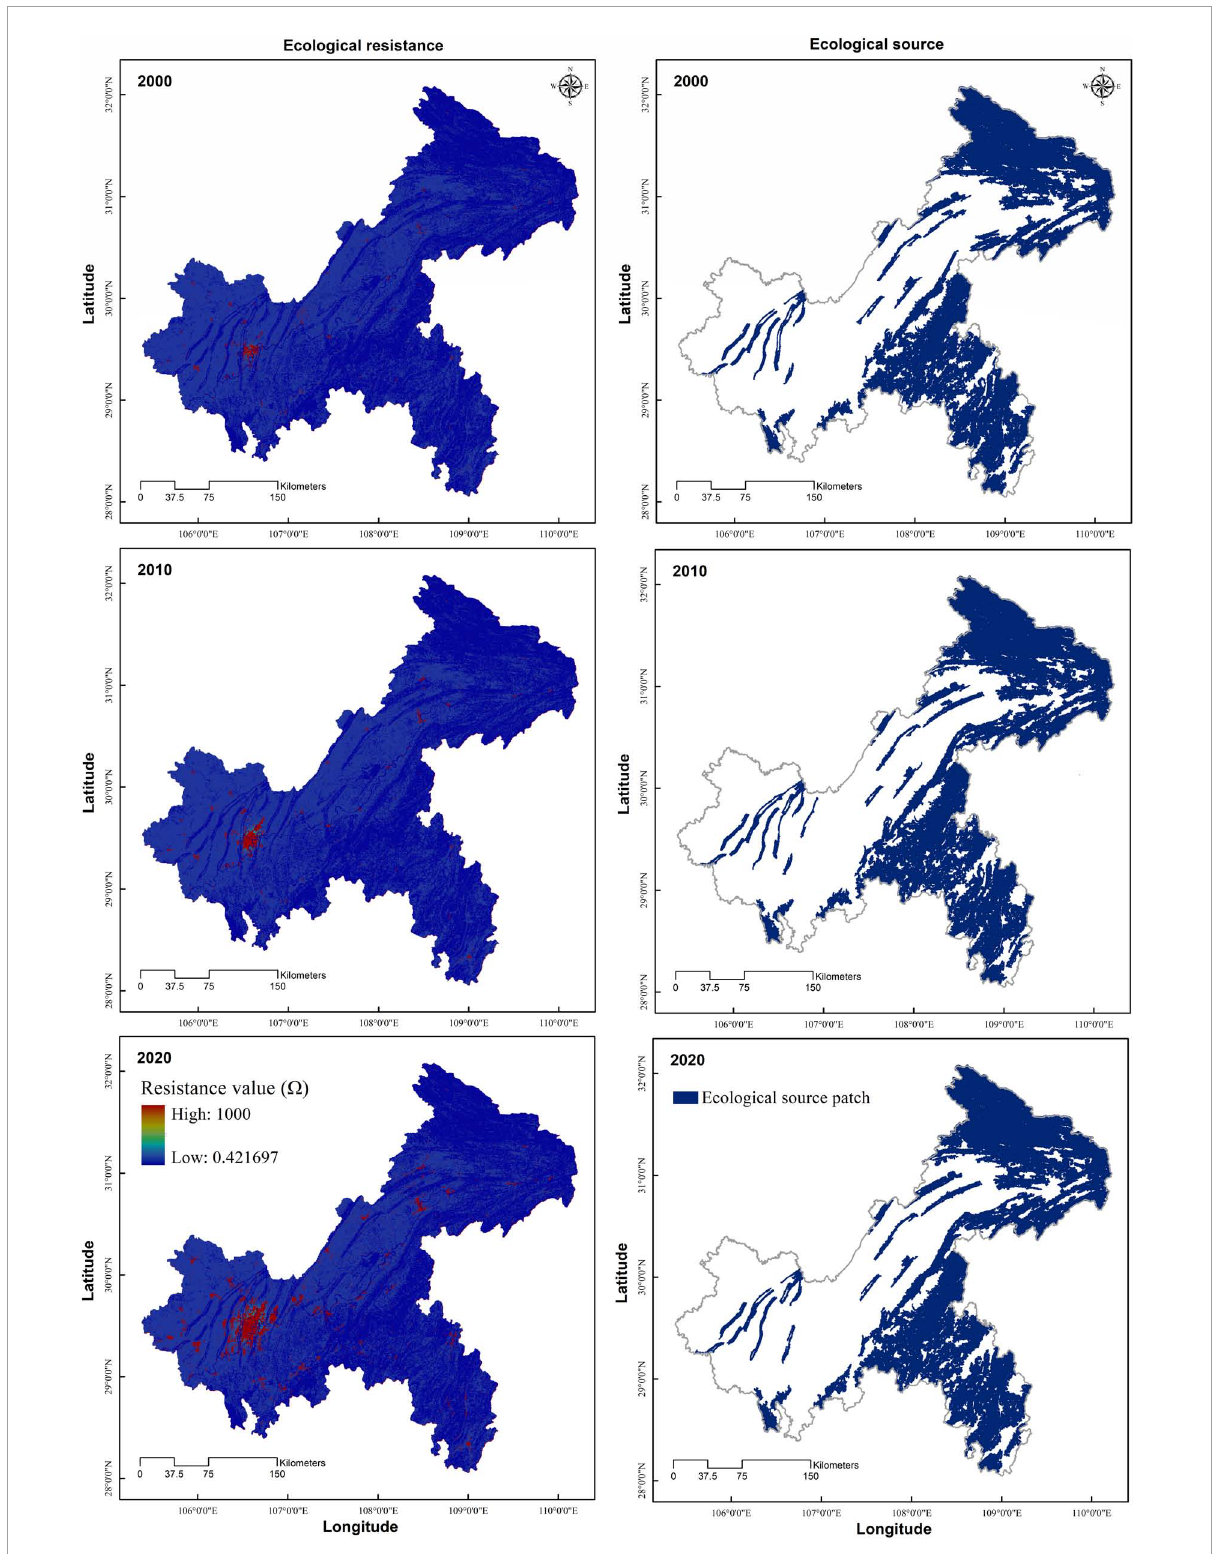
FIGURE4 The ecological resistance layers and ecological source patches of Chongqing Municipality in 2000, 2010, and 2020.